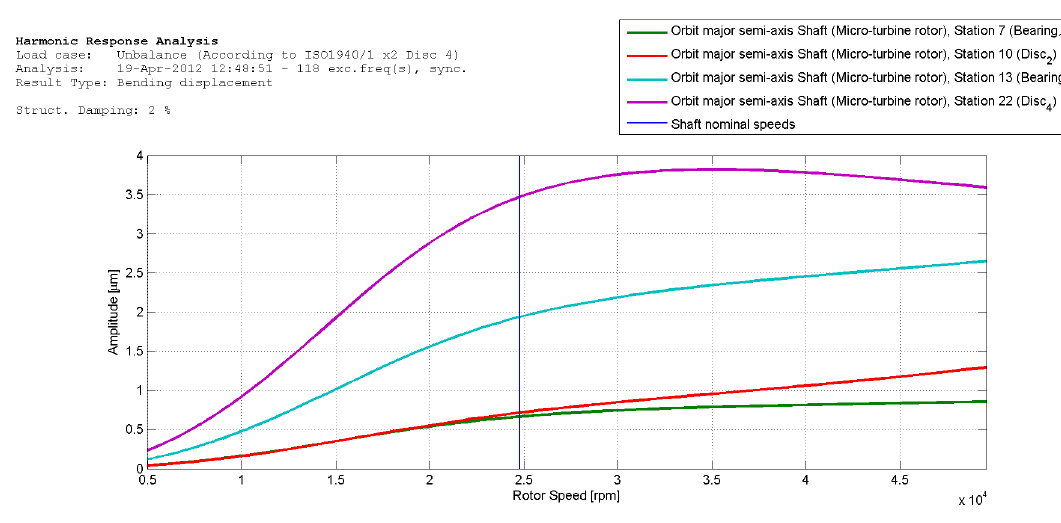
Figure 11: Amplitude of the rotor vibration for the unbalance of the disc No. 4 equal to 2.4 × 10 −6 kg · m.